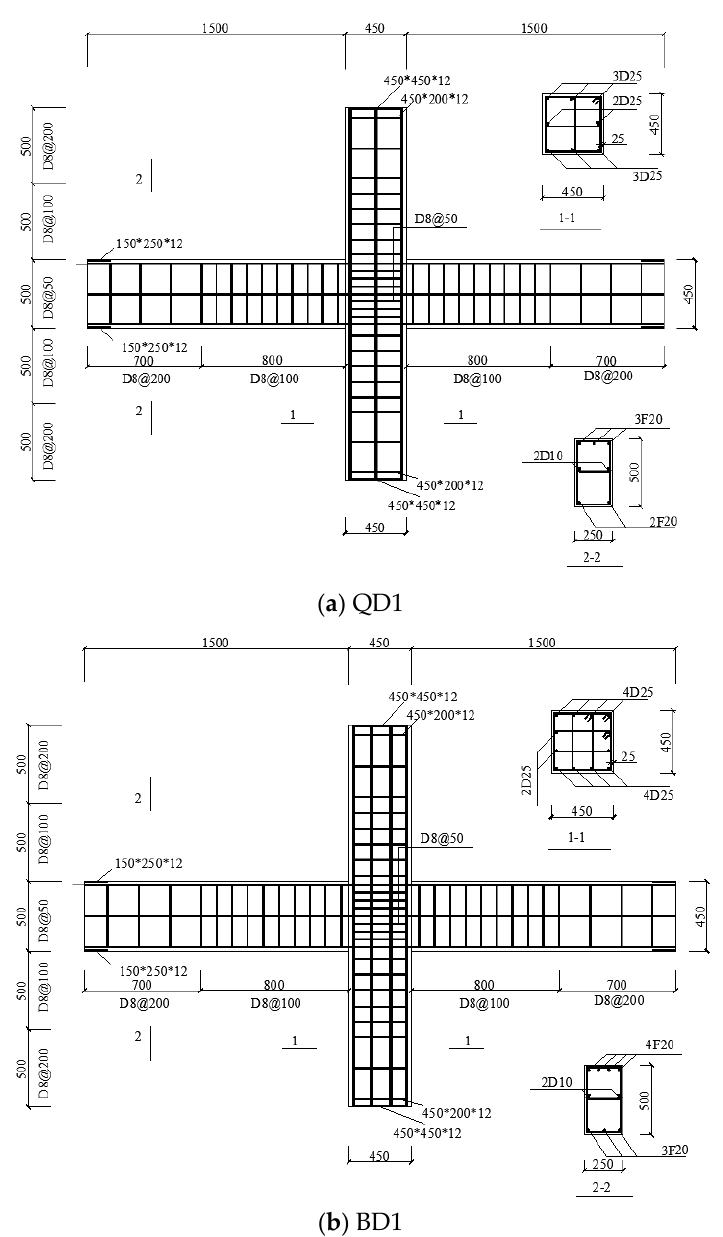
Figure 1. Reinforcement details of specimens ( a ) QD1; ( b )BD1 (mm).